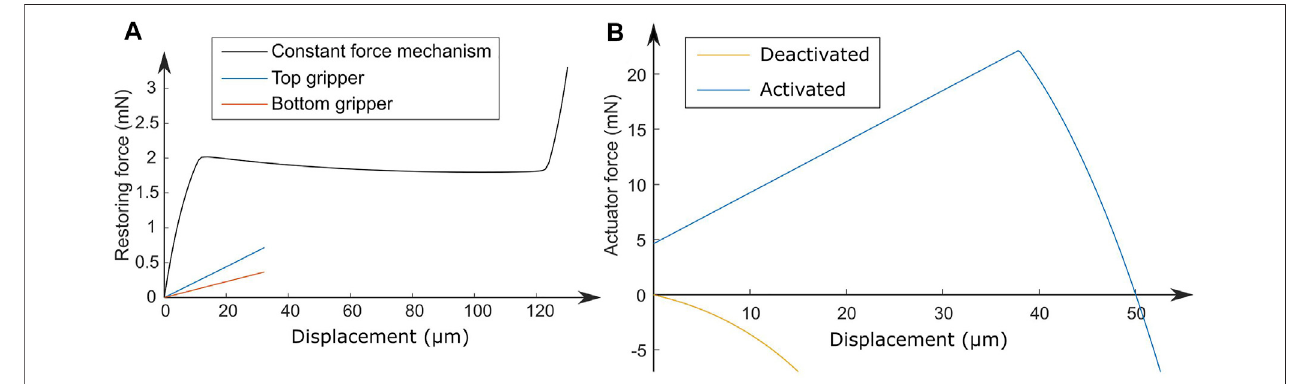
FIGURE 5 | Force – displacement curves for the (A) constant-force mechanism and top and bottom grippers and (B) actuator when it isat rest and activated at the maximum voltage.